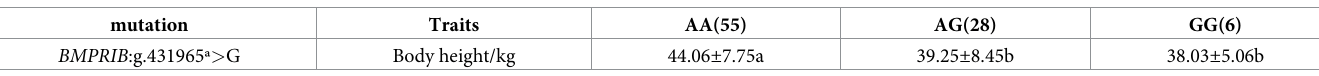
Table 4. Correlation analysis between BMPRIB Gene g.431965A > G locus and growth traits of Qira Black Sheep.